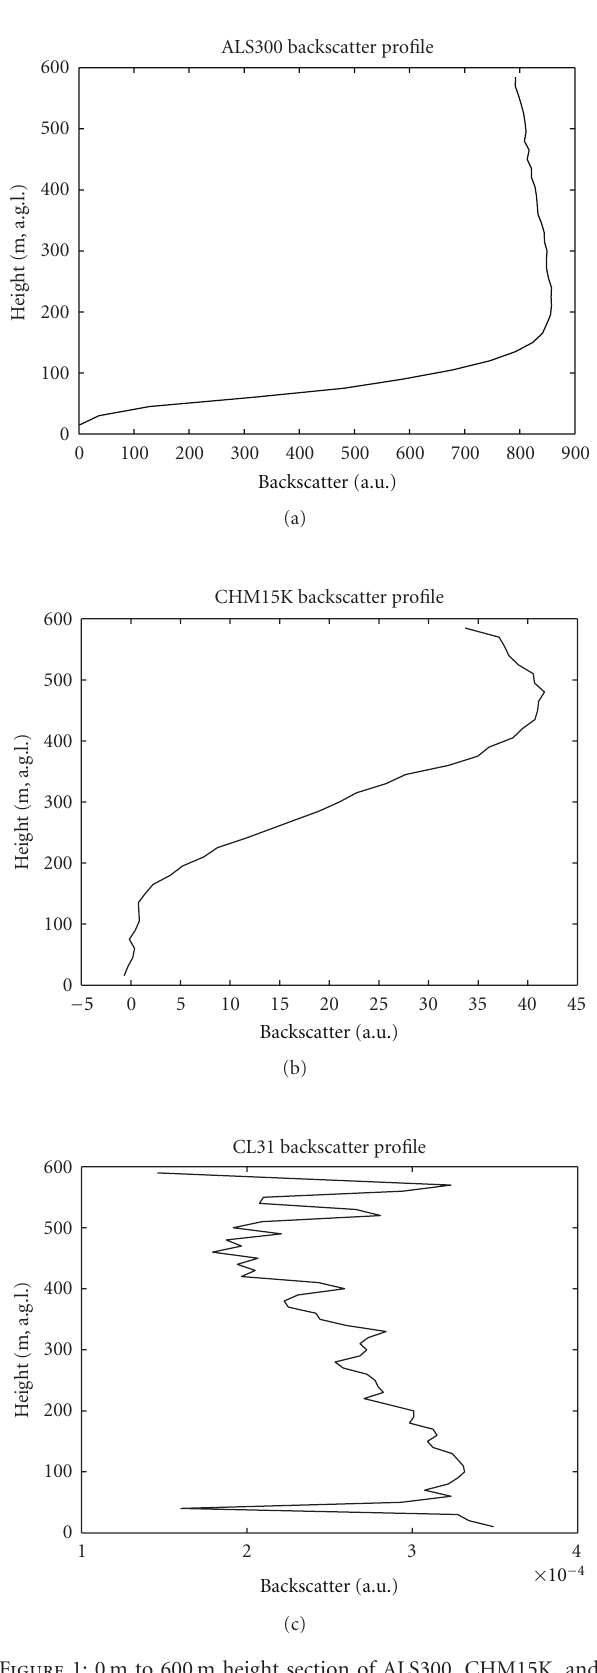
Figure 1: 0 m to 600 m height section of ALS300, CHM15K, and CL31’s 10-minute average of backscatter